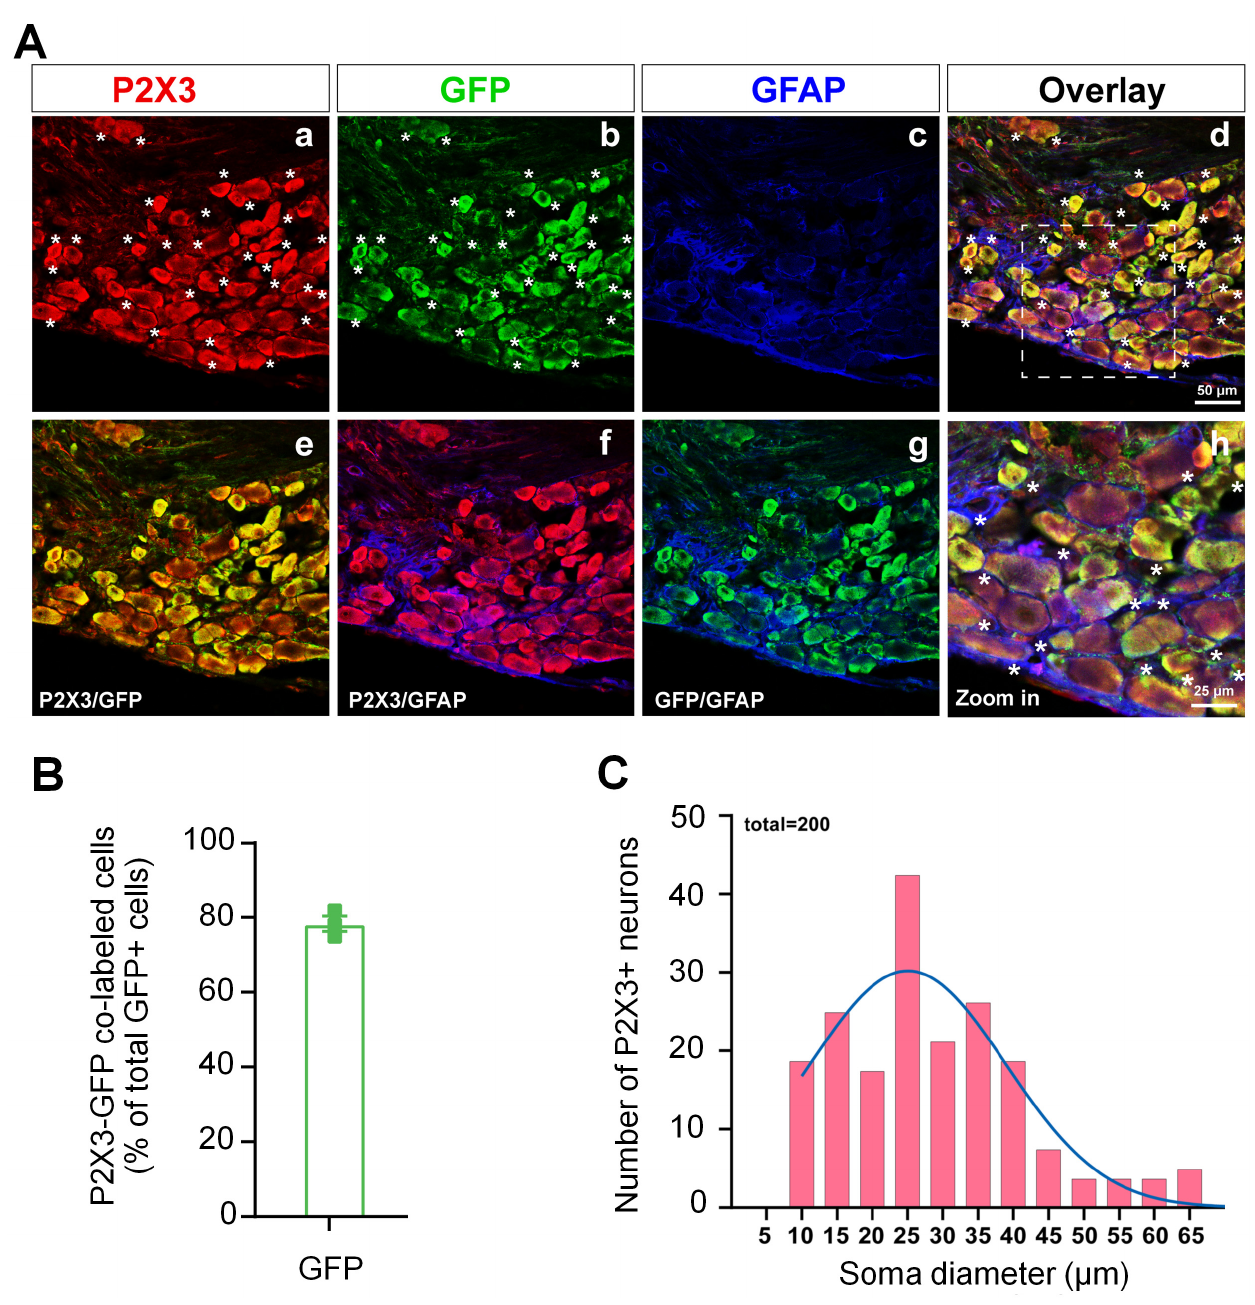
Figure 6. Expression of P2X3 protein in the dorsal root ganglion (DRG) of Pirt -GCaMP6s mice. ( A ) The P2X3 receptor immunoreactivity was detected in neurons, but not satellite glial cells (SGCs), in the DRG of Pirt -GCaMP6s mice. The distribution of P2X3 (red), GFP (green, which labels GCaMP6s- expressing neurons), and GFAP (blue, which labels SGCs) fluorescence signals in the DRG. * indicates P2X3 and GFP co-labeled neurons. (a,b,c) Single-label images of P2X3, GFP and GFAP. (d) An overlaid image of (a–c). (e,f,g) Double-label images. (h) A high-magnification image of the box outlined in (d). ( B ) Quantification of the percentage of P2X3–GFP co-labeled neurons in total GFP-positive neurons ( n = 3 mice). ( C ) Distribution of somata diameters (5 µ m bins) of P2X3-positive (+) neurons from lumbar DRGs of Pirt -GCaMP6s mouse ( n = 200 neurons from 3